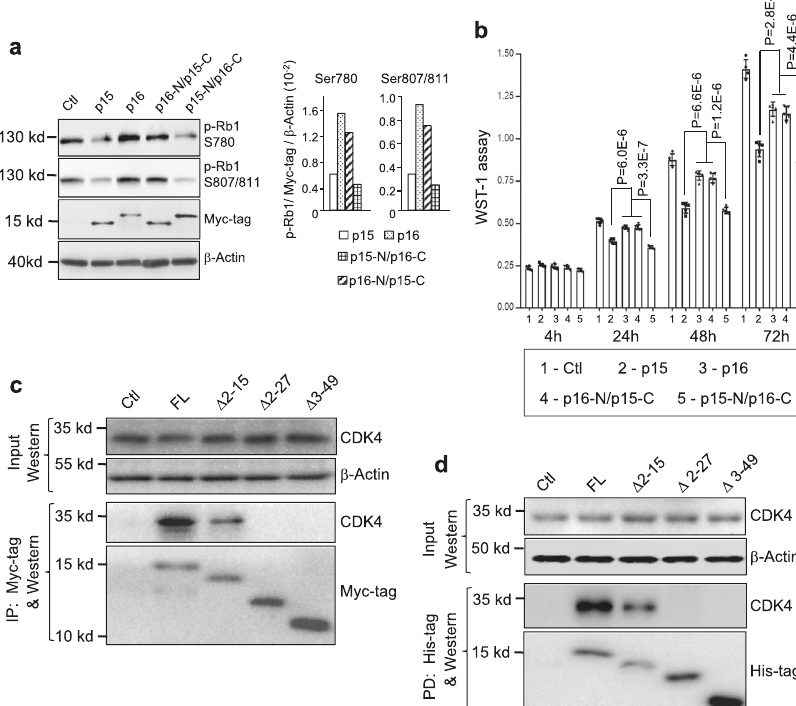
Fig. 5 Critical role of the N terminus of p15 in binding to and inhibiting CDK4 and CDK6. a , b Domain switching between p15 and p16 narrows strong growth inhibitory activity of p15 to its N terminus. Mammalian expression vectors bearing Myc-tagged cDNA hybrids (i.e., p16-N terminus (p16-N) plus p15-C terminus (p15-C)) or p15-N terminus (p15-N) plus p16-C terminus (p16-C)), along with control vectors (Ctl) bearing Myc-tagged wild-type p15 or wild-type p16 were stably transfected and inducibly expressed in UMUC3 cells. pRb1 phosphorylation status 24 h after induced expression of wild type and hybrid proteins ( a ) and cell proliferation with time course indicated ( b ) were assessed by western blotting with semi-quantitation and WST-1 assay, respectively ( a , right panels), were representative semi-quantitation by densitometry of the phosphorylated pRb1 shown in the left panel in reference to Myc-tag and β -actin. The experiments were repeated twice with similar results. b p16 and p16-N/p15-C were statistically compared as one group because of their highly similar readings and compared with p15 and p15-N/p16-C as individual groups. Note that p15-N/p16-C was as effective as wild-type p15 in inhibiting pRb1 phosphorylation and cell proliferation and, in comparison, that p16-N/p15-C was as ineffective as wild-type p16 in inhibiting